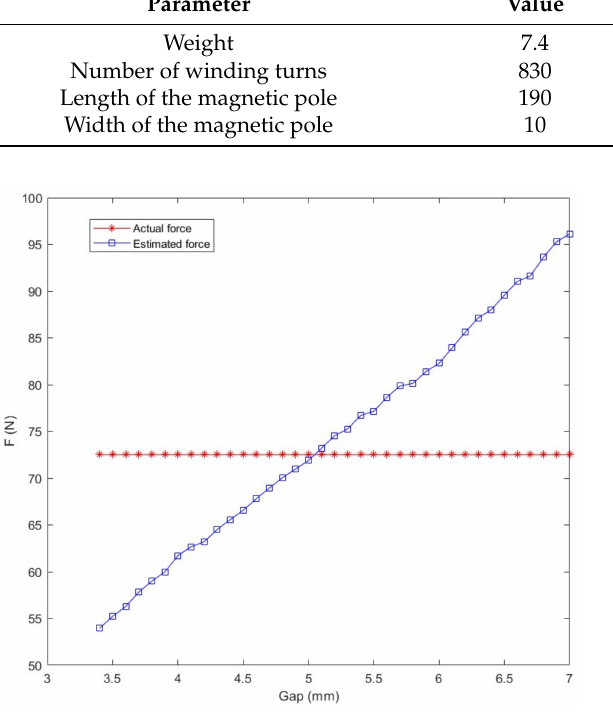
Figure 3. Comparison of the actual electromagnetic forces, and the electromagnetic forces estimated by empirical